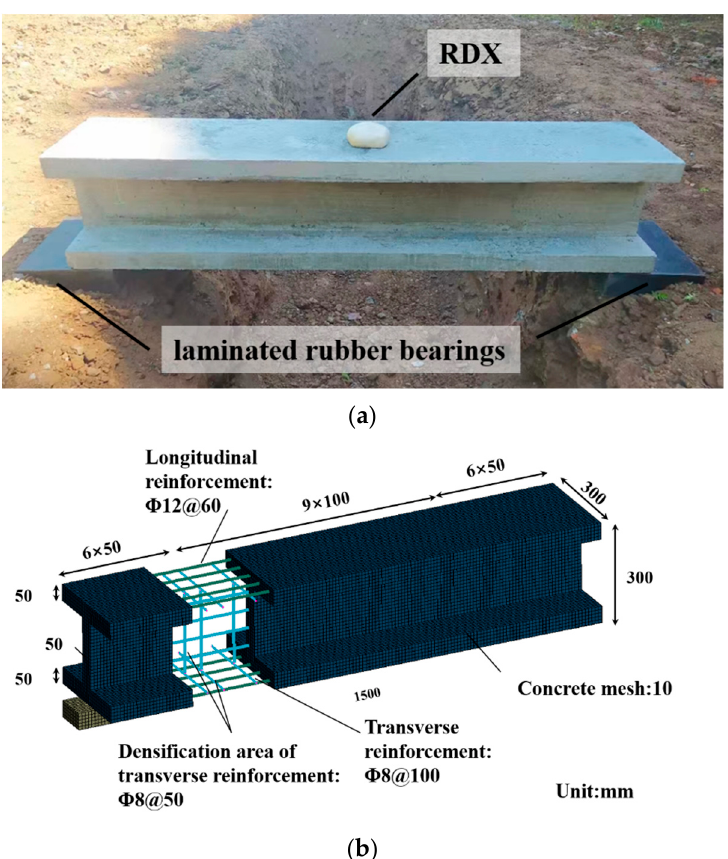
Figure 1. Geometric model of I-shaped RC beam; ( a ) experimental model, and ( b ) numerical model.